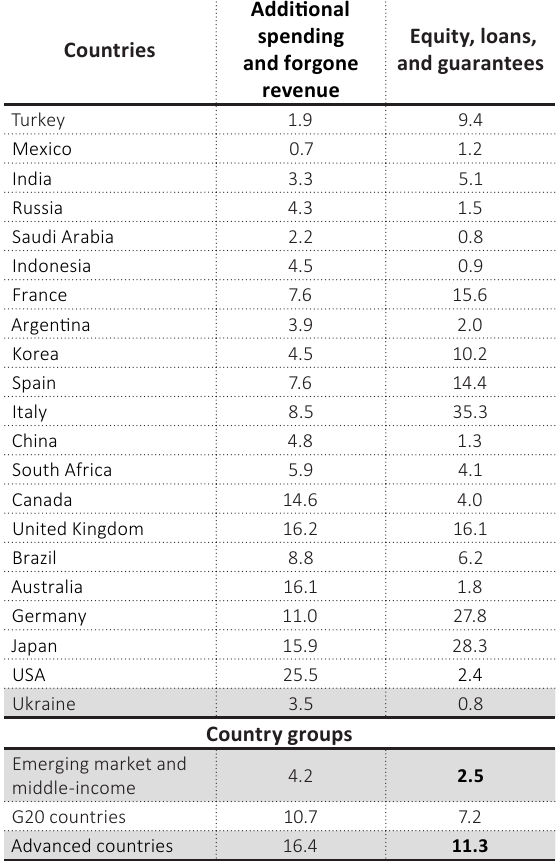
Table 1. Fiscal policy response to the COVID-19 in the country groups and specific countries as a % of the GDP Source: IMF (2021a). Additional spending Equity, loans, Countries and forgone and revenue